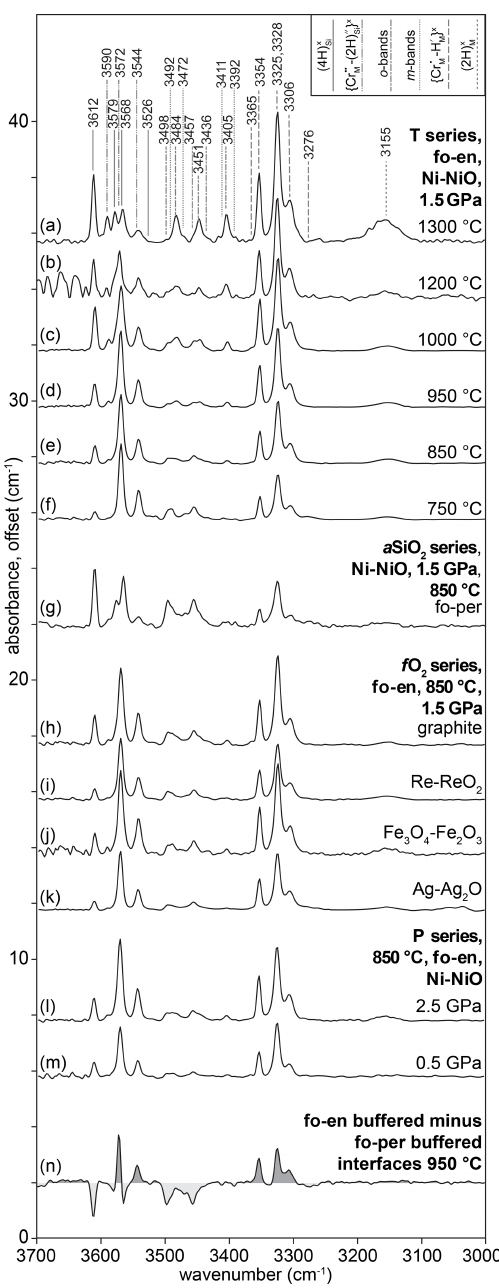
Figure 3. FTIR spectra, offset for clarity. (a–m) Examples of spec- tra recorded at the crystal “interface”. In (a–m) , these were acquired at ∼ 30µm from the true interface and represent the first spectrum in a profile without any contamination from epoxy resin. The spectra are separated into groups, with an offset of 4 between groups, based on the variable being investigated. Spectrum (n) shows the differ- ence between interface spectra from samples buffered by fo-en or fo-per at 950 ◦ C. Areas shaded dark grey show greater absorbance in enstatite-buffered conditions; light grey areas are associated with greater absorbance in periclase-buffered conditions.